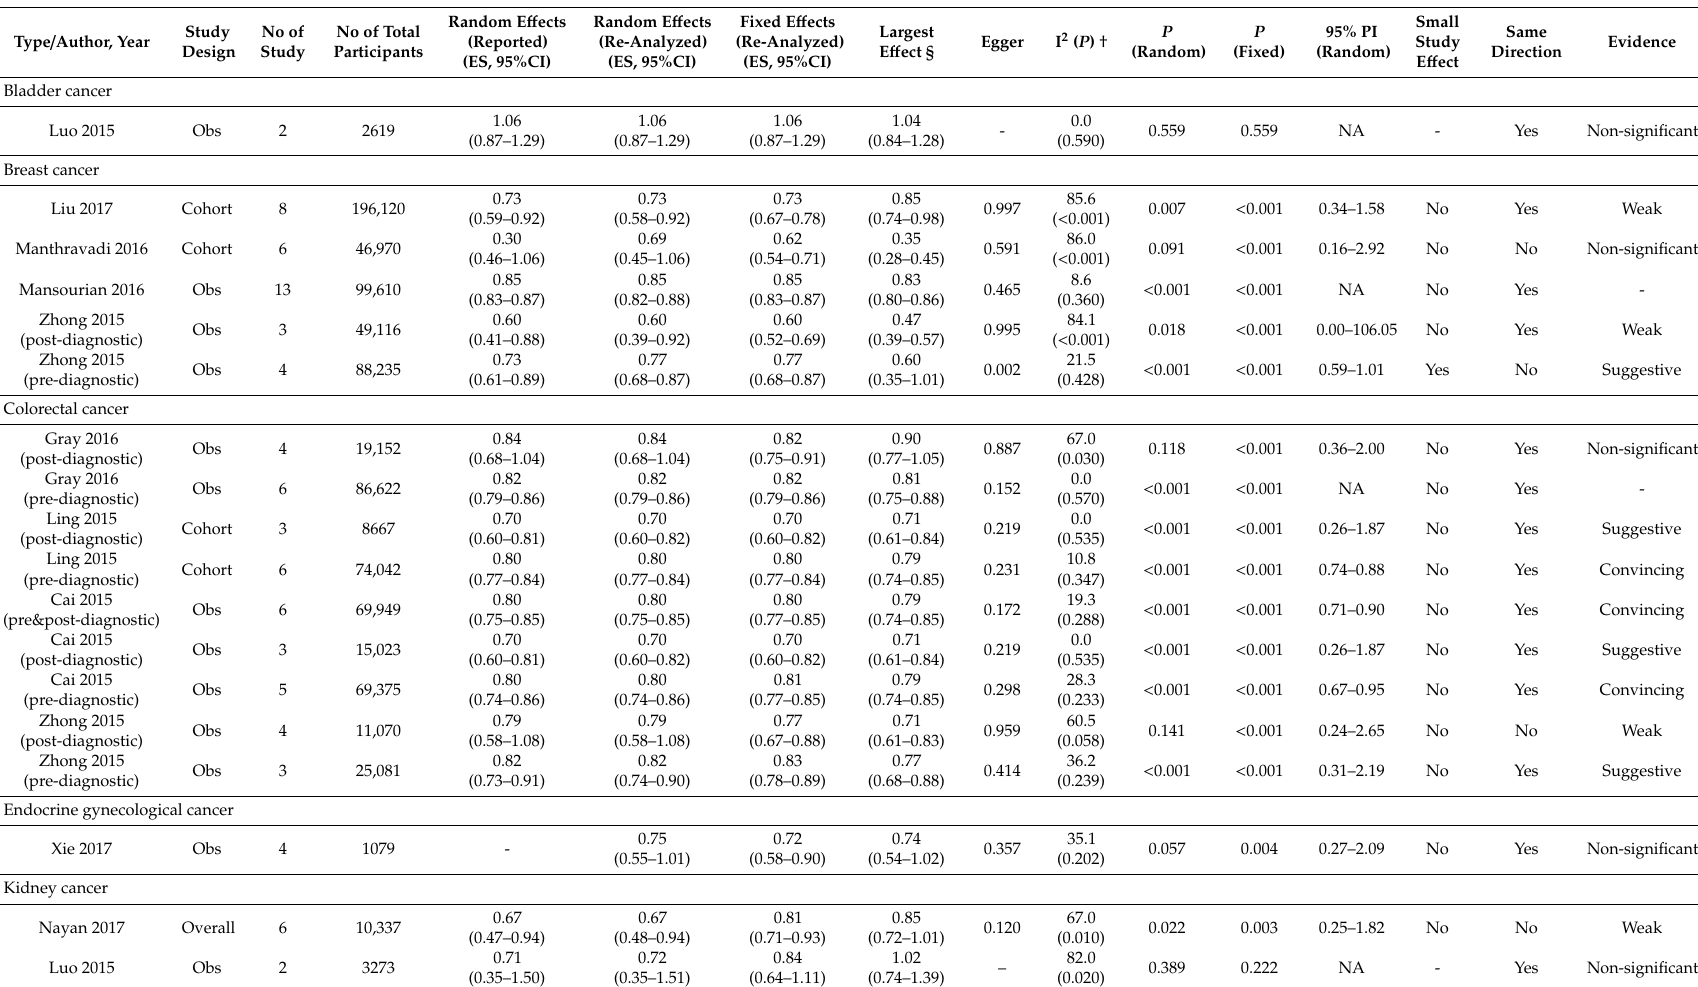
Table 2. Summary of each individual meta-analysis on associations of the use of statin and cancer-specific mortality in various